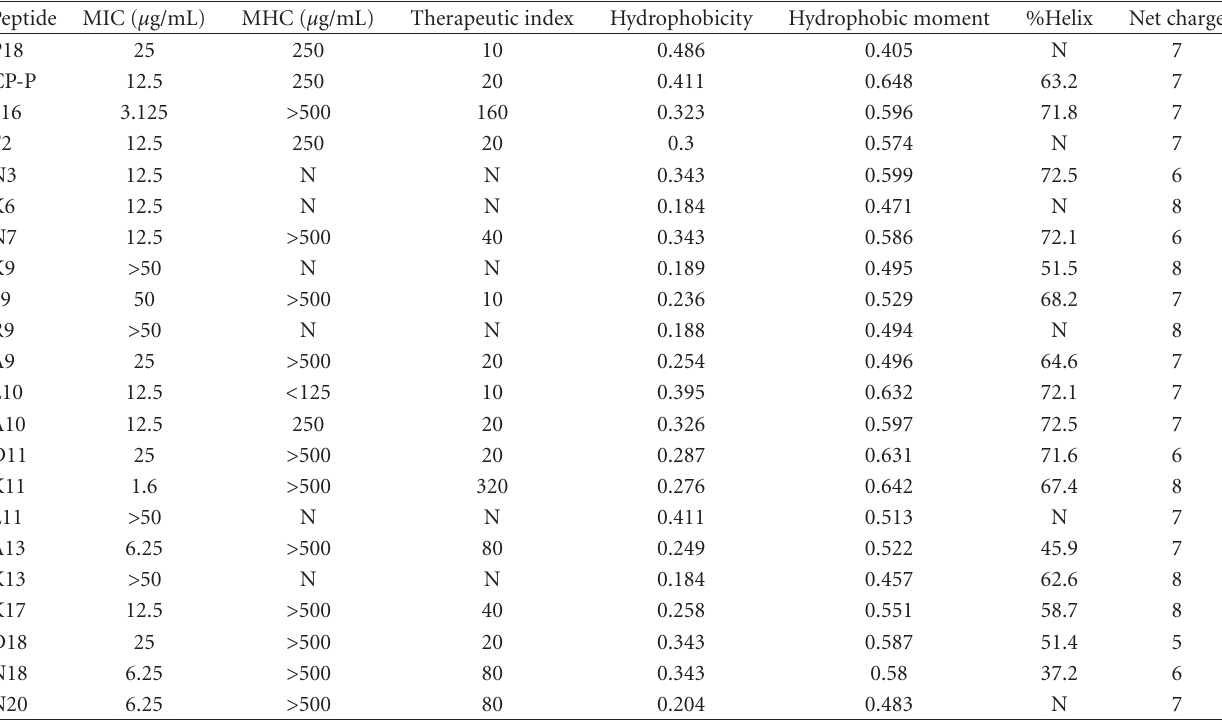
Table 2: The MICs, MHCs, and therapeutic indices of the designed